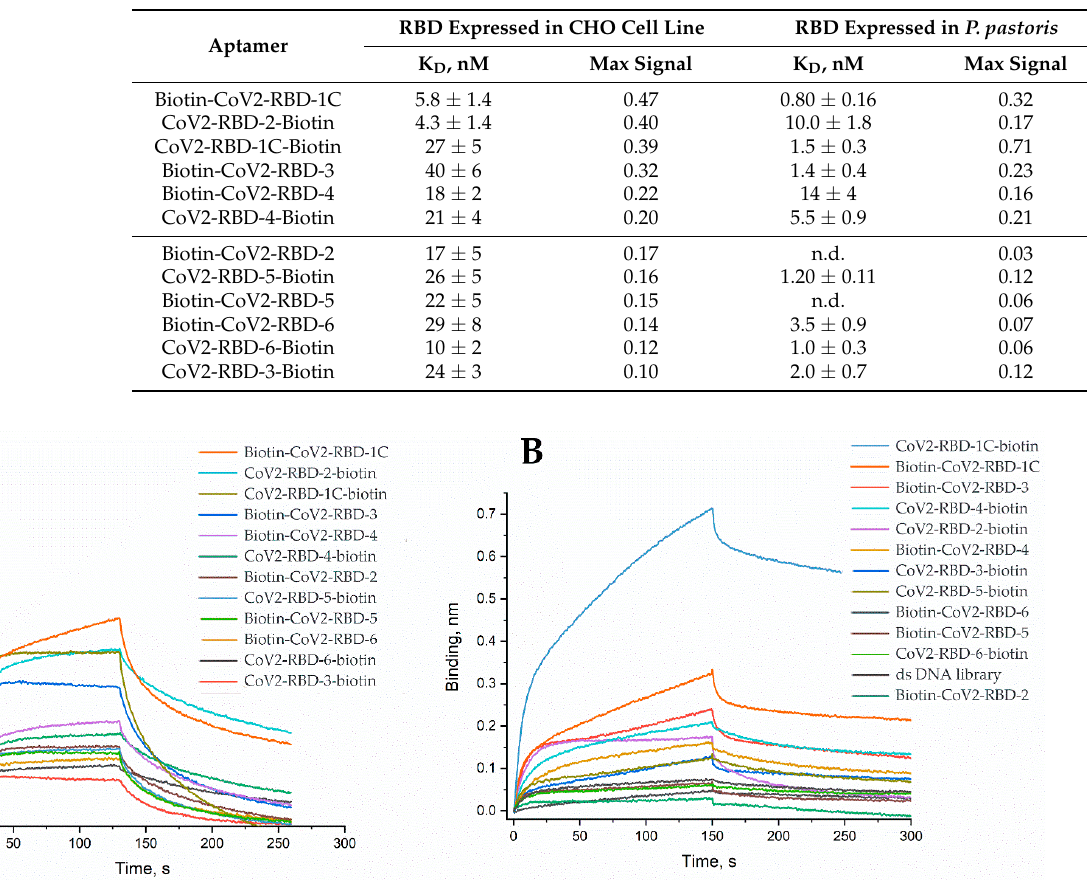
Figure 1. Binding curves of immobilized biotinylated aptamers to RBD proteins expressed in Chinese hamster ovary cell line ( A ) and Pichia pastoris ( B ). The concentration of RBD proteins was 100 nM. Table 1. Estimated dissociation constants for aptamer-RBD complexes and maximal signal of the binding curves in 100 nM solution of RBD protein. Aptamers are ranged according to maximal sig- nal of the binding curves for RBD protein expressed in CHO cell line. n.d.—not determinable due to low signal.